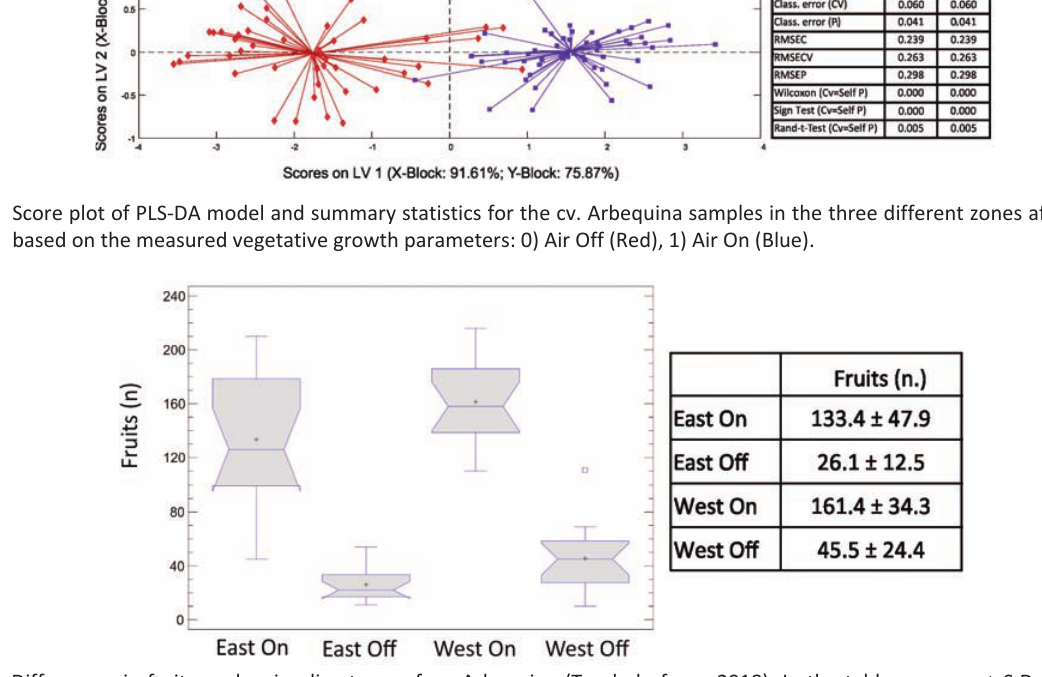
Fig. 5 - Differences in fruit number in olive trees of cv. Arbequina (Tombolo farm, 2018). In the table: average ± S.D.; in the Box and Whisker plot: median notches, and average (+) ± S.D.